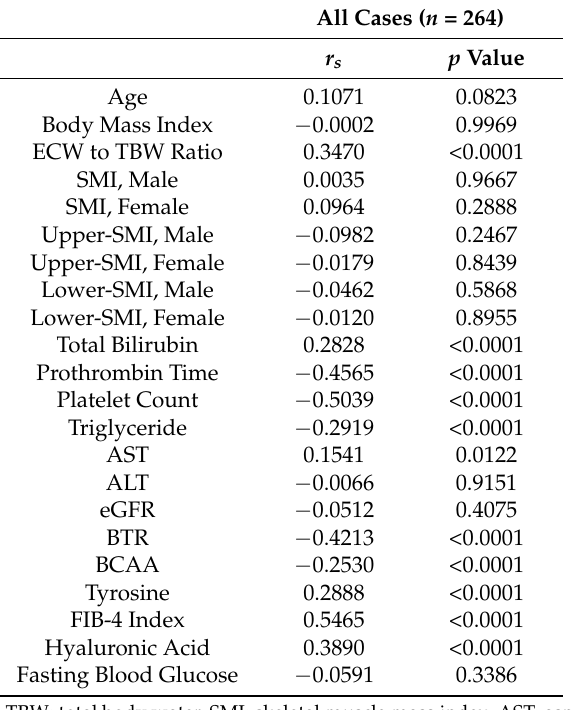
Table 3. Relationship between CONUT score and baseline